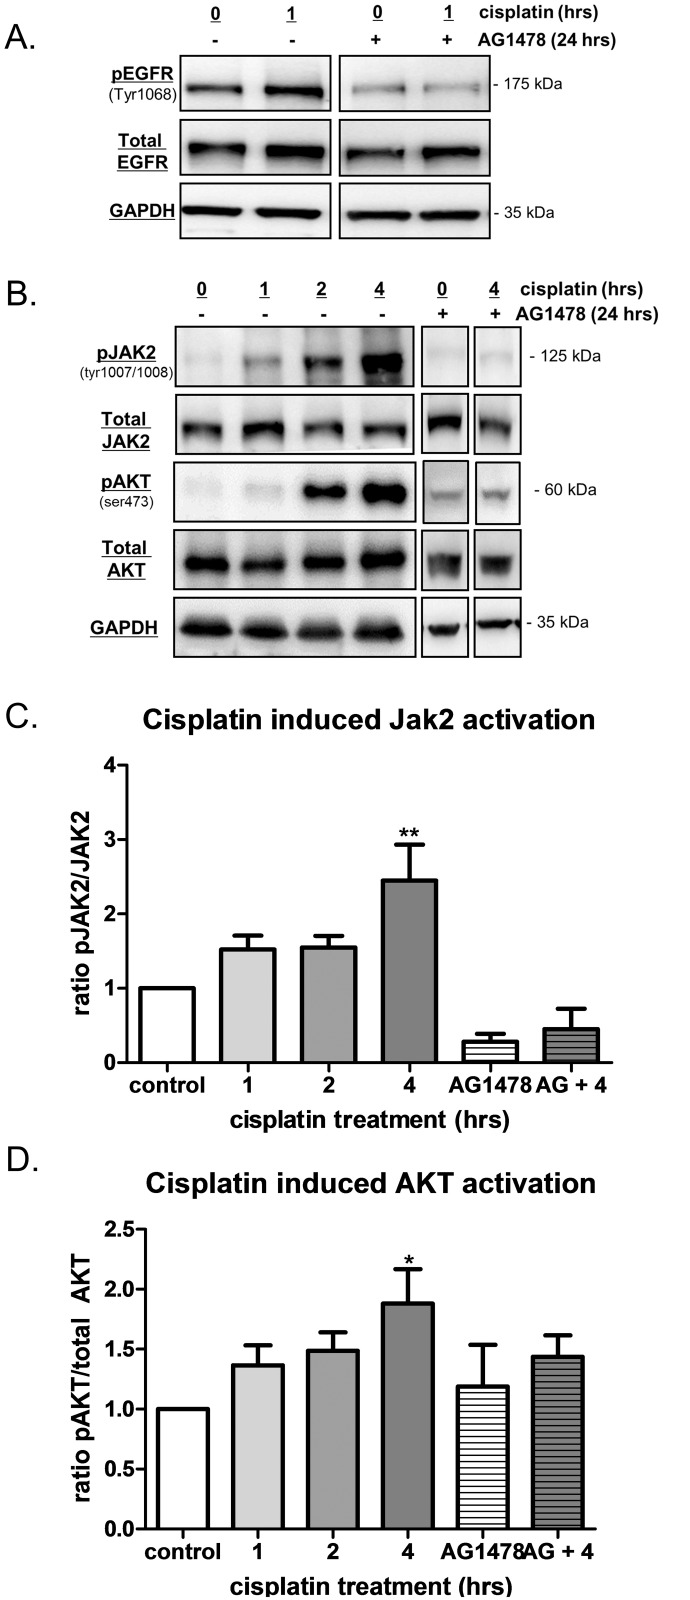
Acute cisplatin induces functional activation of the EGFR thereby activating downstream signaling pathways JAK2 and AKT.A) Representative western blots of pEGFR, Total EGFR and GAPDH of OVCA 433 cells-/+ 10 μM cisplatin for 1 hour in the presence and absence of the EGFR specific inhibitor AG1478 (2 μM, for 24 hour pre-incubation). B) Representative western blots for pJAK2 (tyr1007/1008), total JAK2, pAKT (ser473), total AKT and GAPDH. OVCA 433 cells-/+ 10 μM cisplatin for 1–4 hours and in presence of AG1478. The data generated for the following graphs represent at least 4 independent experiments i.e. ~4 different treatment/collection groups and ~4 different immunoblots. C) Ratio of JAK2 activation (pJAK2/total JAK2) data obtained after 10 μM cisplatin treatment for 1–4 hours and in the presence of AG1478, n = 4–6. Significant increases from control samples observed at 4 hours of cisplatin treatment. AG1478 pre-incubation for 24 hours blunted basal levels of activated JAK2 as well as cisplatin induced increases in JAK2 activation at 4 hours (AG+4). D) Ratio of AKT activation (pAKT/total AKT) data obtained after 10 μM cisplatin treatment for 1–4 hours and in the presence of AG1478, n = 4–7. Significant increases from control samples observed at 4 hours of cisplatin treatment. AG1478 pre-incubation for 24 hours blunted cisplatin induced increases in AKT activation at 4 hours (AG+4). One-way ANOVA revealed a significant effect of drug treatment and following Dunnet’s post hoc test significant differences from controls are indicated by *p<0.05, **p<0.01.